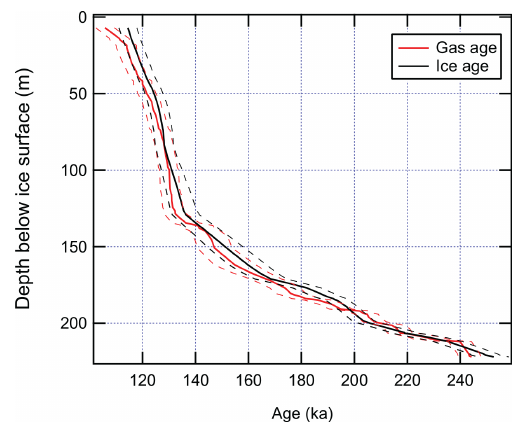
Figure 6. Depth profile of gas age (red) and ice age (black) in S27. Dashed lines represent the 95% uncertainty of the absolute age.